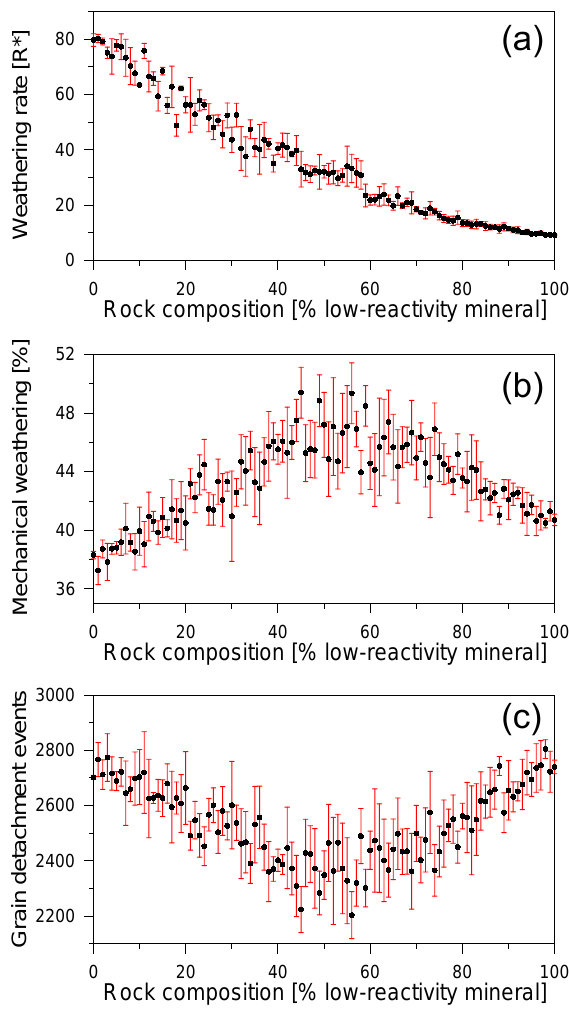
Figure 5. Impact of rock composition on weathering. (a) Weath- ering rate in R ∗ units versus composition; (b) ratio of mechanical weathering to total weathering as a function of composition; and (c) the number of detachment events versus composition. Black cir- cles show the average of six different realizations for each compo- sition, while the red bars show the standard deviation. The stochas- tic nature of dissolution and the random position of low-reactivity grains in the simulated rocks causes variation in the weathering rate between rocks with the same composition. The weathering rate decreases nonlinearly with the addition of low-reactivity minerals. When there are approximately equal proportions of high- and low- reactivity minerals, mechanical weathering reaches a maximum, al- though the actual number of detachment events is at a minimum.